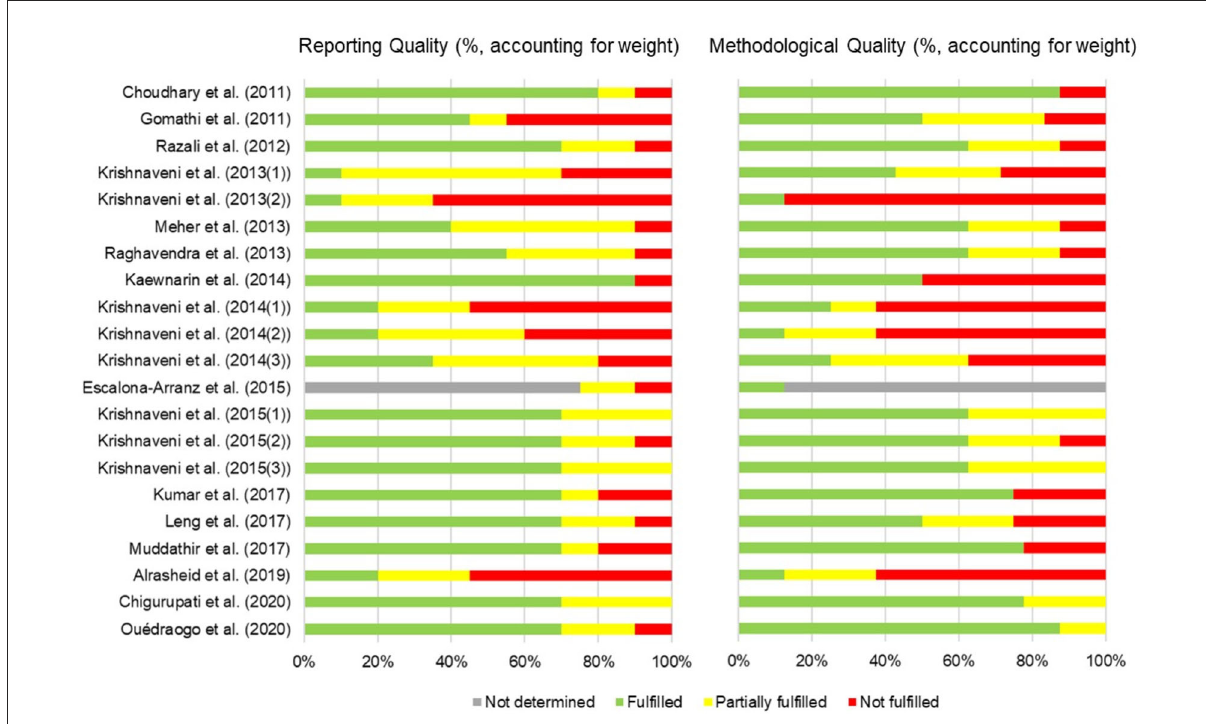
FIGURE2 Risk of bias summary assessment of included studies. The bars represent the reporting quality and methodological quality of individual studies resulting from the average of the quality of (1) test compound and controls (2) test system (3) administration of test compound and (4) data collection and analysis. The evaluation used SciRAP with adaptation as a tool (25).